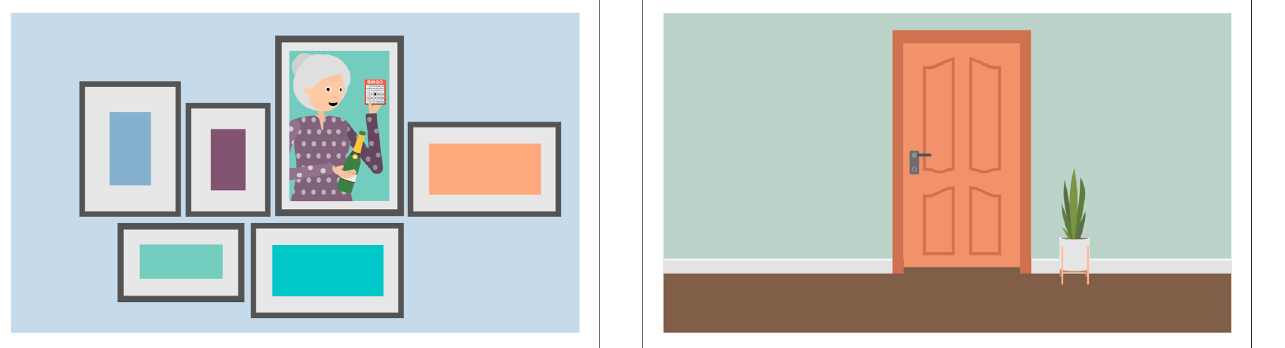
FIGURE 2 | Illustration used in VWT role-play interview showing Rose.